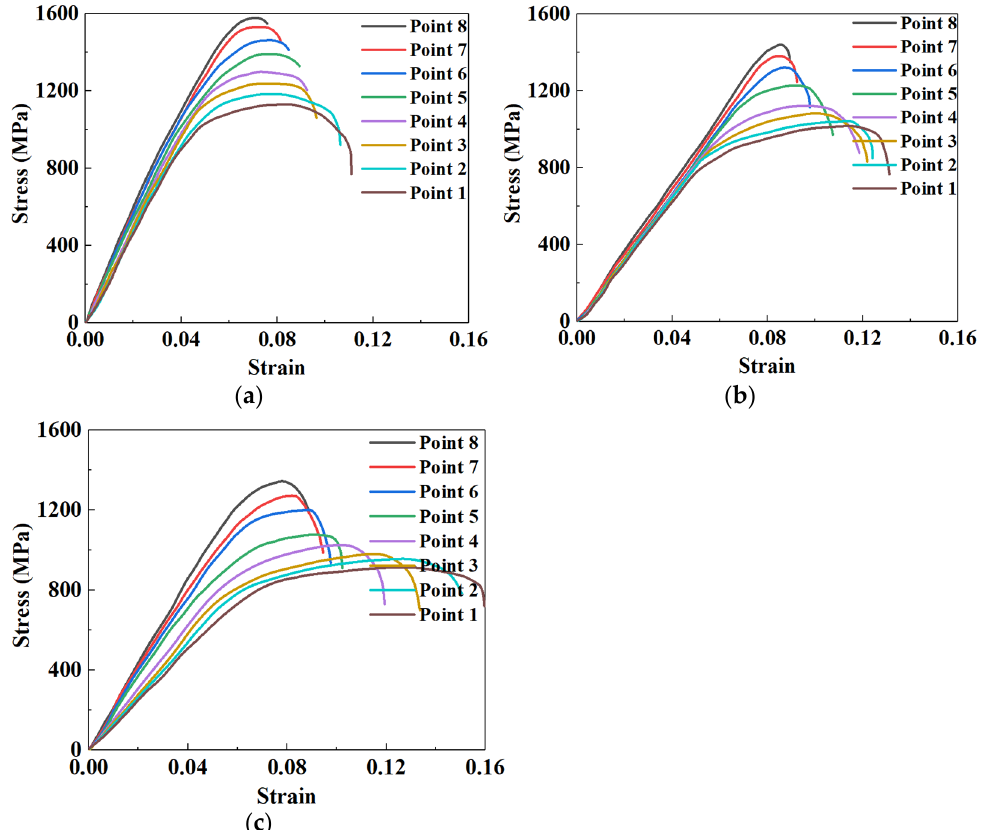
Figure 13. Stress–strain curves of different tensile specimens under the quenching time of ( a ) 10 s, ( b ) 20 s, and ( c ) 30 s.